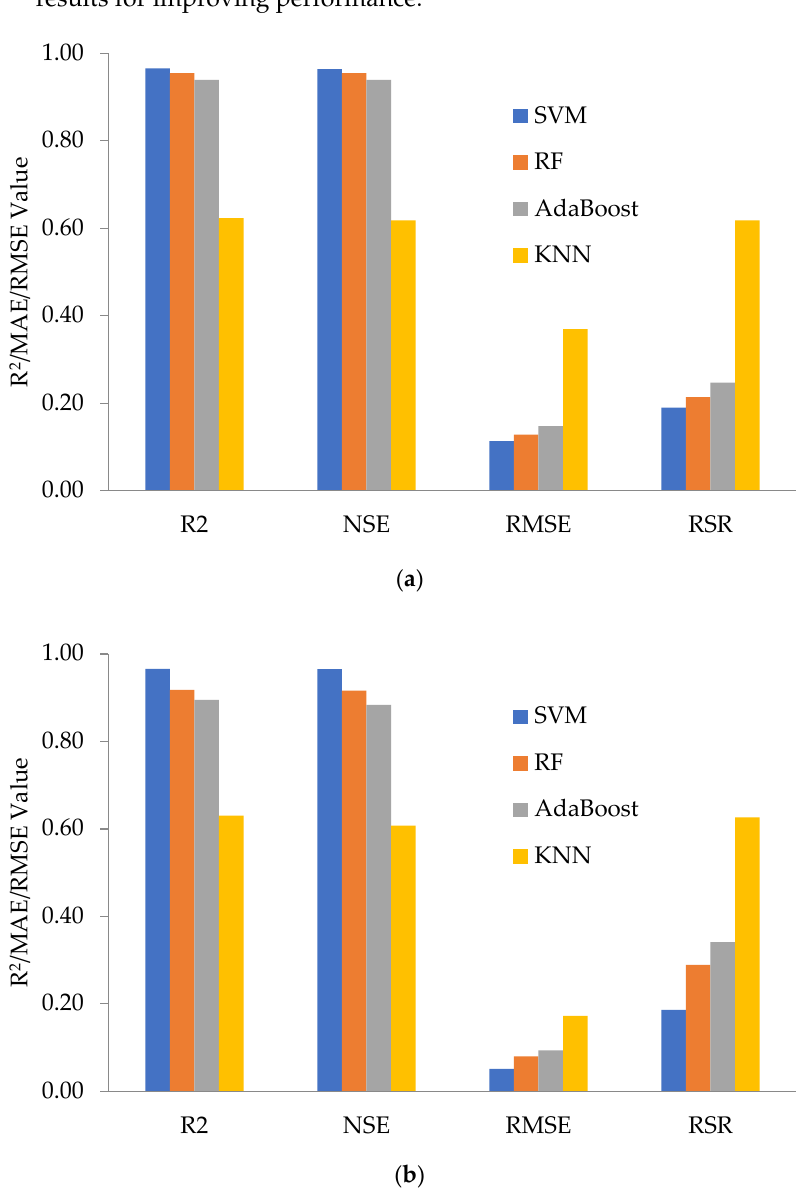
Figure 5. Comparison of R 2 , NSE, RMSE, and RSR values from the SVM, RF, AdaBoost, and KNN models in ( a ) training phase and ( b ) testing phase.